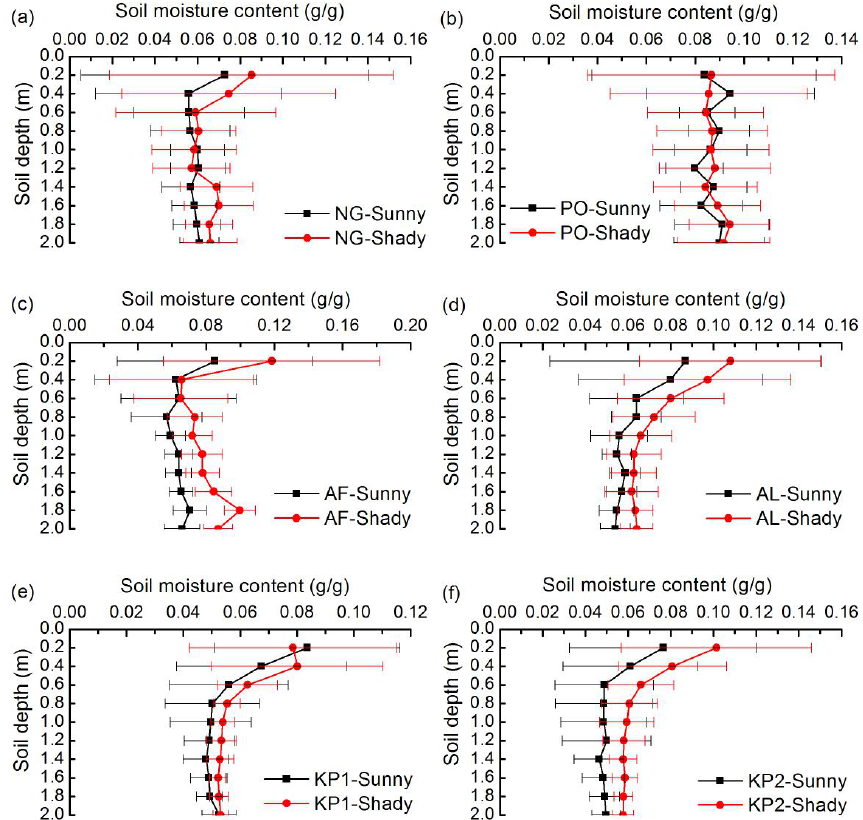
Fig. 4. Comparison of temporal-averaged shallow soil moisture content (SMC) on different slope aspects. Note: NG represents native grass- land; PO represents farmland planted with potato; AF represents abandoned farmland; AL represents alfalfa; KP represents korshinsk peashrub. The number of samples of shallow soil moisture content was 26. Sunny refers to sunny slope and shady refers to shady slope. For example, NG-Shady refers to native grassland on shady slope, and NG-Sunny refers to native grassland on sunny